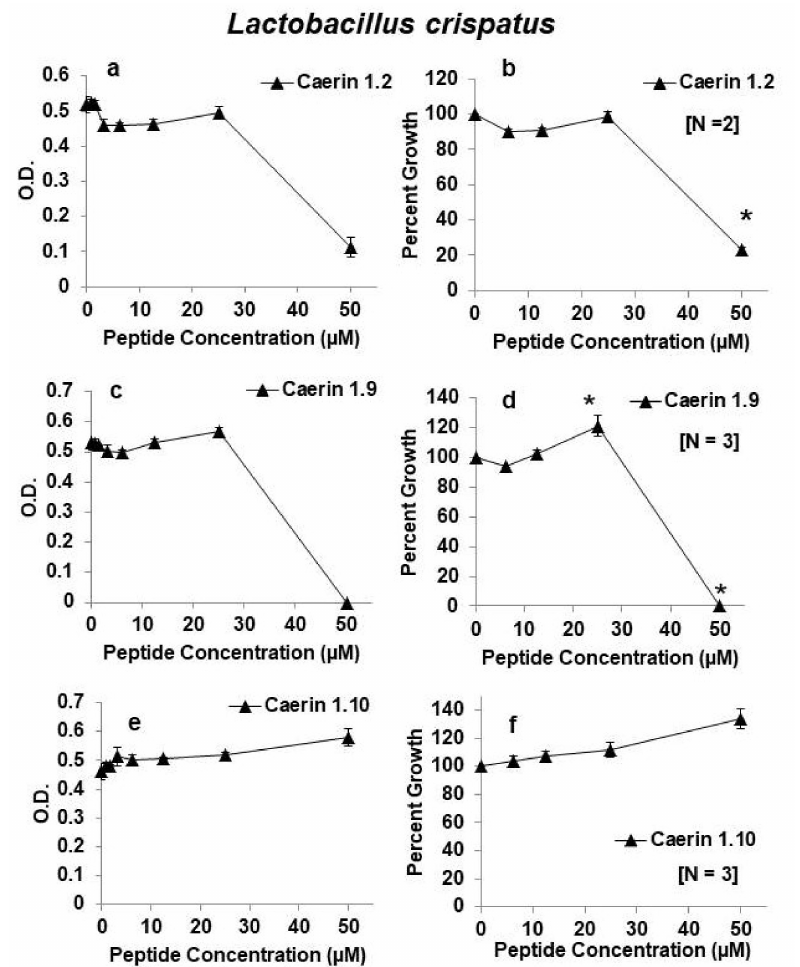
Figure 3. E ff ects of caerin 1 peptides on growth of Lactobacillus crispatus. ( a , b ) caerin 1.2; ( c , d ) caerin 1.9; ( e , f ) caerin 1.10. Panels on the left show growth as changes in optical density (O.D.) at 630 nm for one representative experiment testing the peptides at increasing 2-fold concentrations from 0.4 or 0.8 to 50 µ M. Panels on the right show the average as percent growth in comparison with the positive (no peptide) control set at 100% for replicate experiments for the range of concentrations from 6.25–50 µ M. The number of replicate experiments for each peptide is shown in brackets within the panel. * Significantly di ff erent growth in comparison with the positive control, p < 0.01 by one-way ANOVA with Tukey’s post hoc